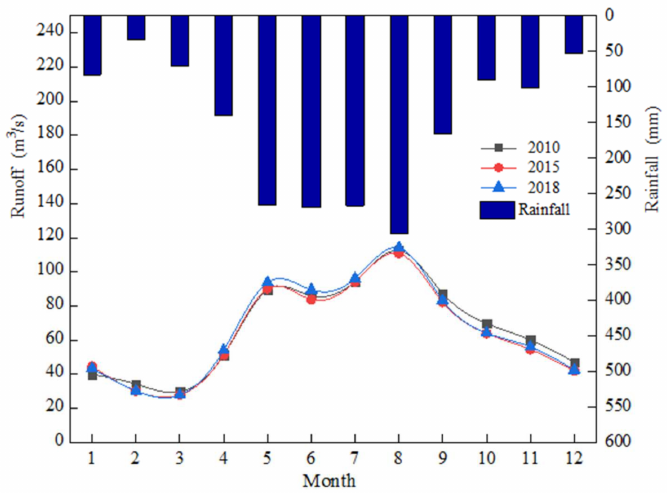
Figure 6. Simulation results of monthly average runoff, under three land use